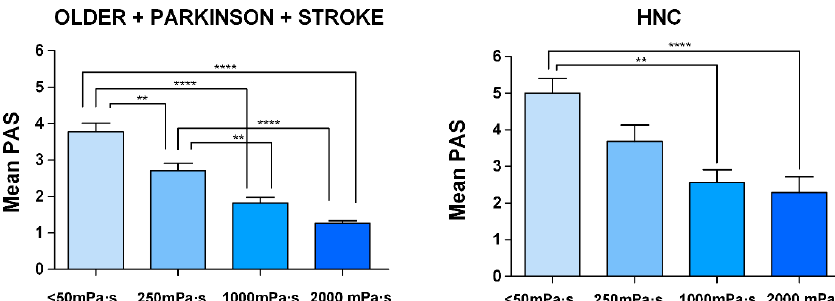
Figure 7. Mean penetration-aspiration scale (PAS) score in each viscosity comparing 3 groups together vs. HNC. Left: older, Parkinson’s and stroke patients; right: patients with head and neck cancer. * p -value < 0.05, ** < 0.01, *** < 0.001, **** < 0.001. HNC: Head and neck cancer.